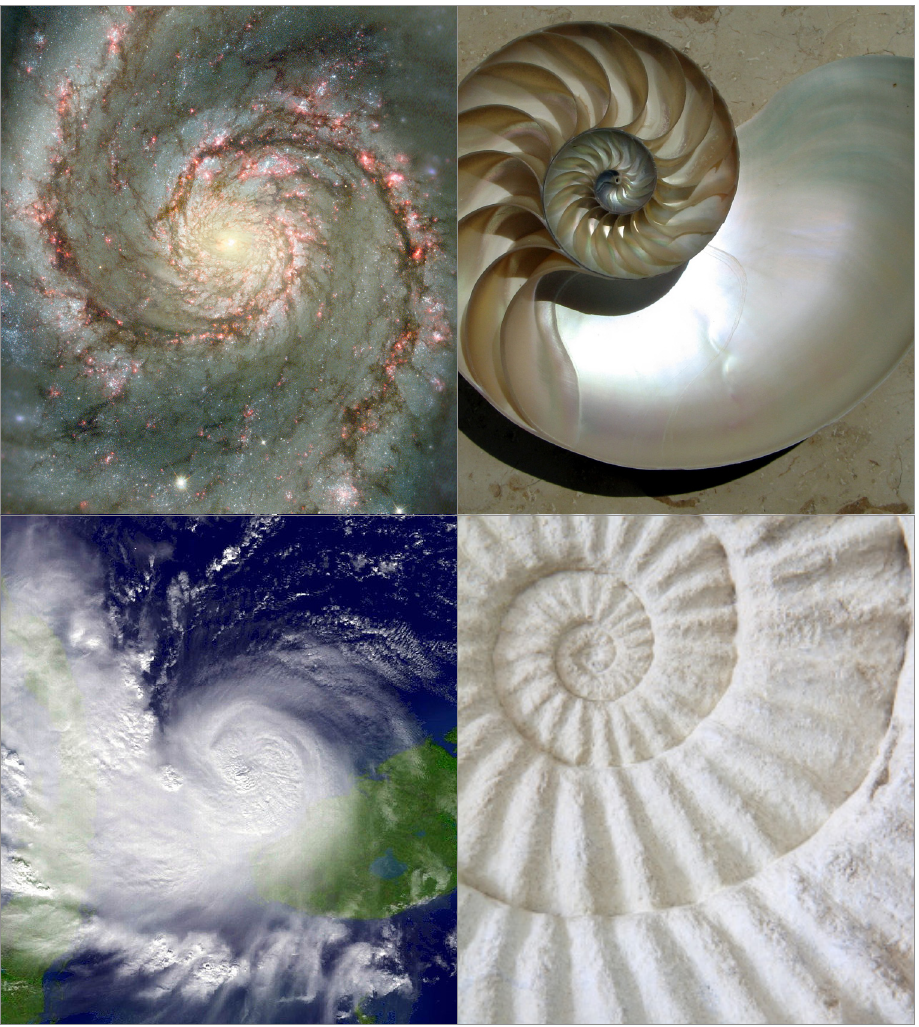
Figure 1: Examples of logarithmic spirals found in nature: (from left to right) the Whirlpool Galaxy, a Nautilus shell, Hurricane Katrina and an